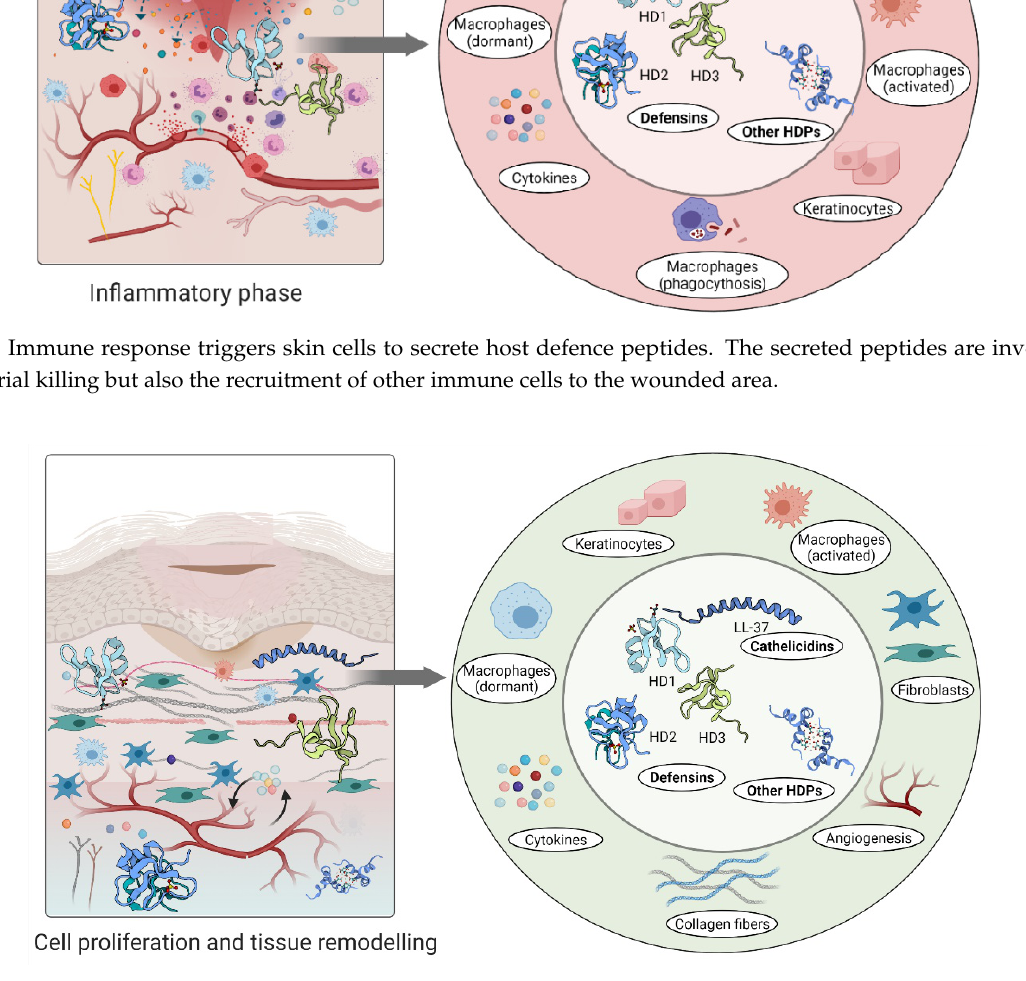
Figure 3. Immune response triggers skin cells to secrete host defence peptides. The secreted pep- tides are involved in antibacterial killing but also the recruitment of other immune cells to the wounded area.